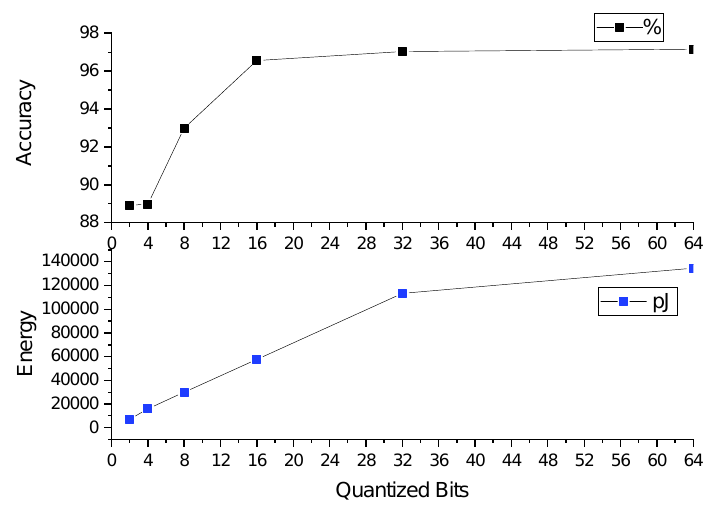
Figure 12. Relationship between quantization bits, accuracy, and energy consumption.